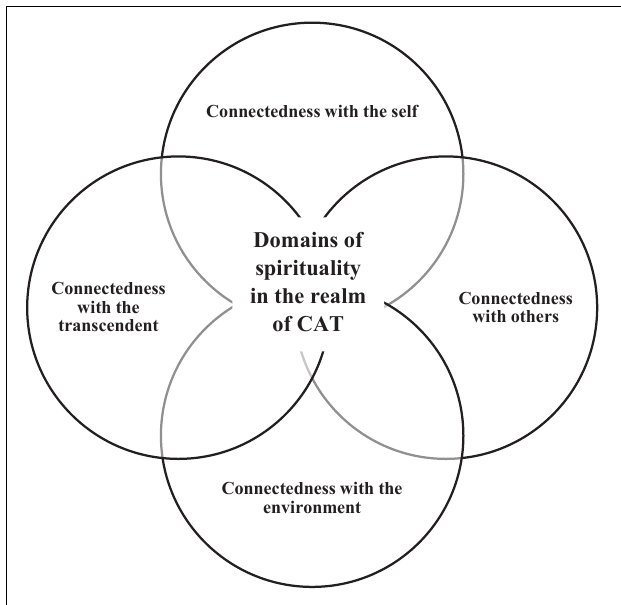
FIGURE 12 | Visual representation of the interconnected nature of the domains of spirituality in